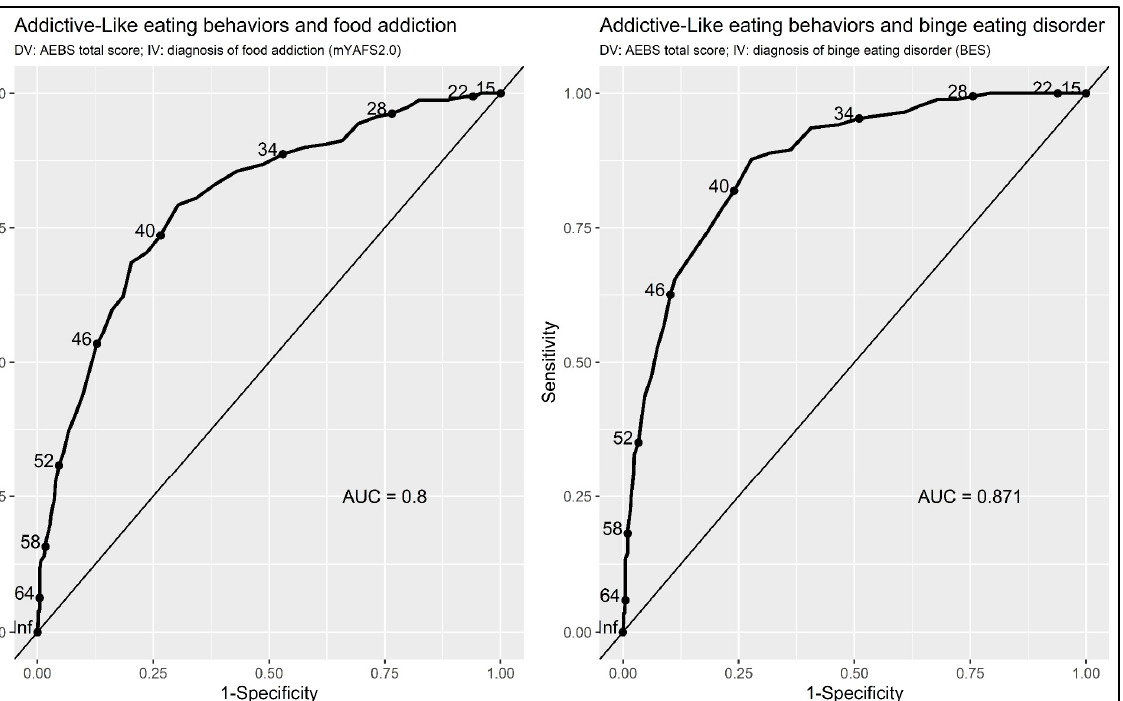
Figure 2. Correlations among variables.